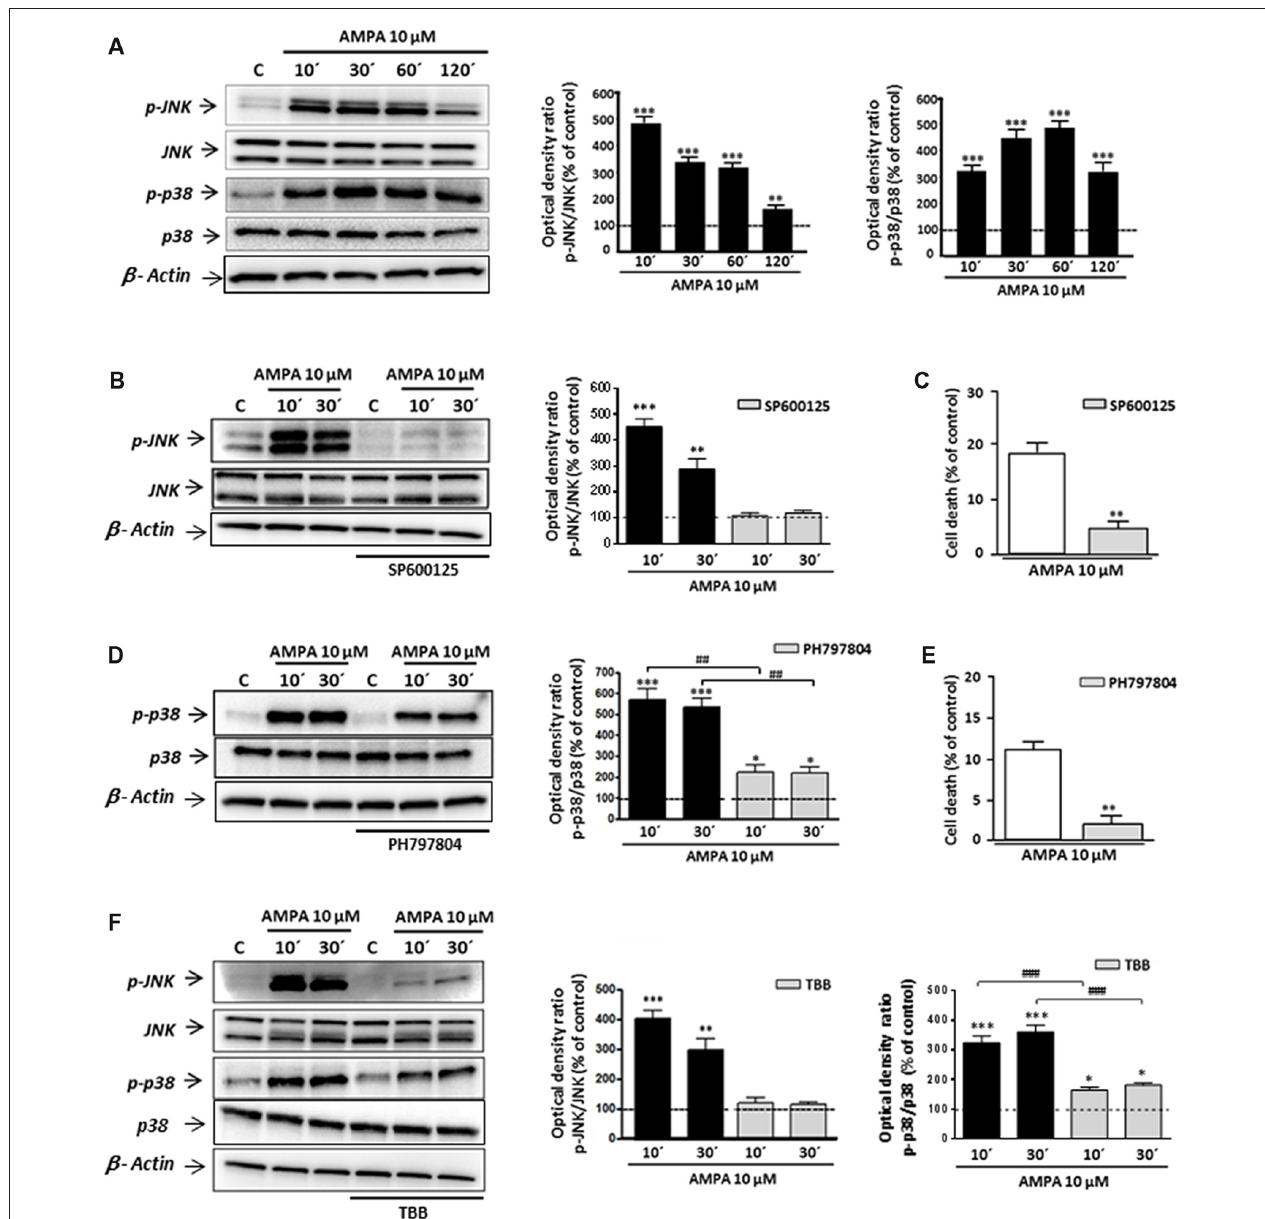
FIGURE 3 | AMPA-induced c-Jun N-terminal kinase (JNK)/p38 apoptotic activation depends on CK2 activity. Oligodendrocytes were treated with 10 µ M AMPA for 30 min, in the presence of 100 µ M CTZ, and total lysates were harvested at the indicated times. When indicated, the stimulus was performed in the presence of the corresponding inhibitor. (A) Activation of AMPA receptors triggered an early and potent increase in the JNK and p38 phosphorylation levels at 10, 30, 60 and 120 min after AMPA treatment, determined by WB analysis. (B,D) The early AMPA-induced activation of JNK and p38 was prevented by the presence of 1 µ M inhibitor SP600125 or PH797804, respectively. (C,E) The inhibition of JNK or p38 by SP600125 or PH797804, significantly reduced cell death induced by AMPA receptor activation in oligodendrocytes. (F) Intense JNK and p38 phosphorylation induced by exposure to AMPA was significantly reduced in the presence of CK2 inhibitor (TBB; 5 µ M) at both times analyzed (10 and 30 min post-stimuli). ∗ p < 0.05, ∗∗ p < 0.01, ∗∗∗ p < 0.001 (cells treated with AMPA vs. control cells); ## p < 0.01, ### p < 0.001 (cells treated with each mitogen-activated protein kinases (MAPKs) inhibitor vs. cells treated with only AMPA).